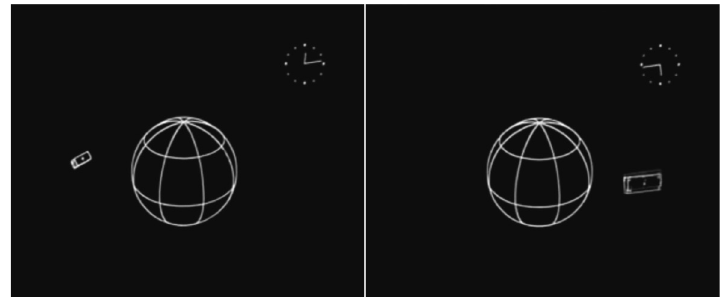
Fig. 1. Frames from the animation prepared by E.